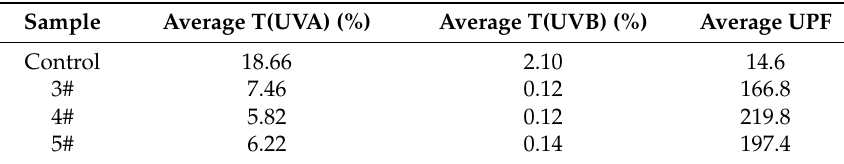
Table 3. Ultraviolet resistant properties of sample.